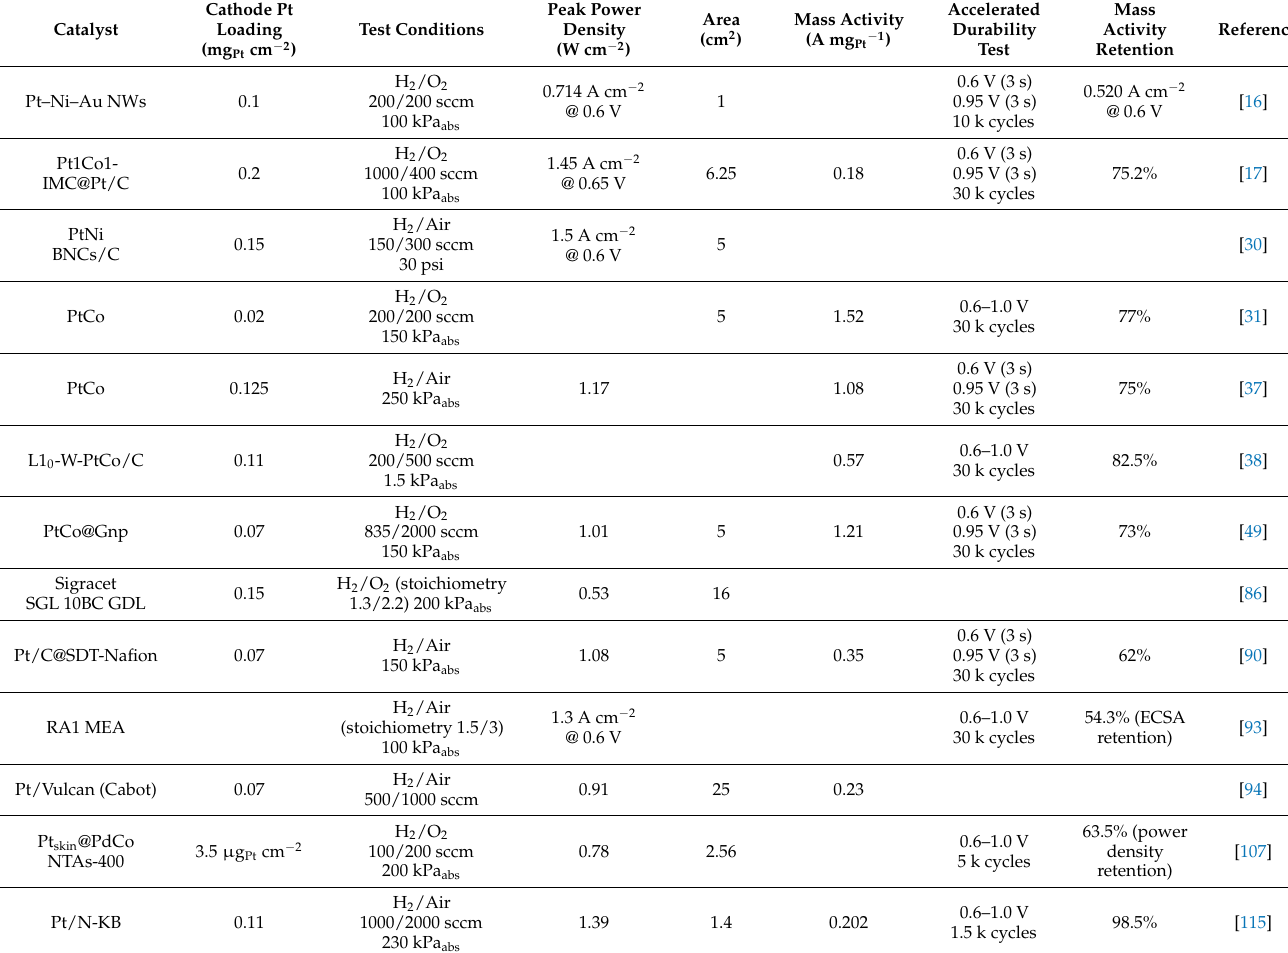
Table 2. Properties of MEAs with different structures and